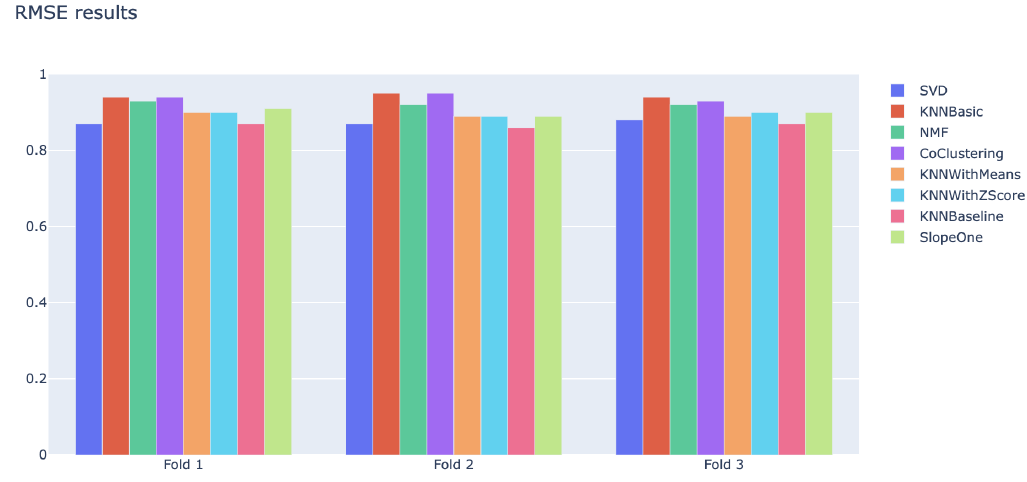
Figure 8. RMSE results using Model-based collaborative filtering.